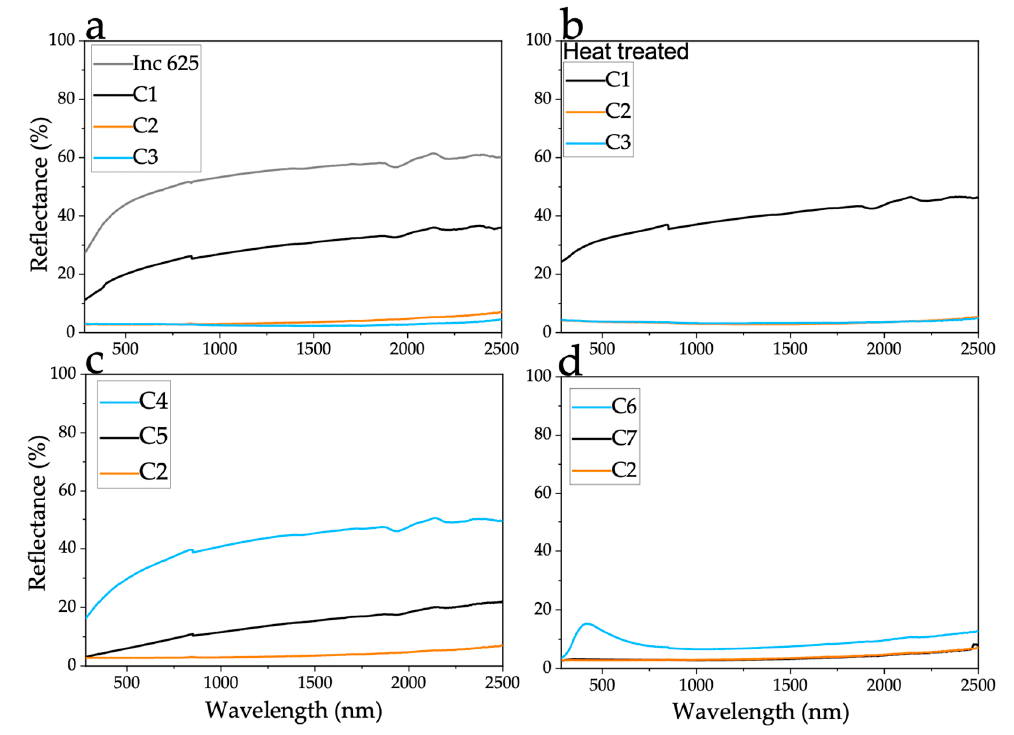
Figure 7. UV-VIS-NIR reflectance of samples. ( a ) as-converted samples at different laser beam power, ( b ) heat-treated samples at 900 ◦ C for 1 h, ( c ) as-converted samples with different amounts of precursor deposited, ( d ) as-converted precursor at different O 2 concentrations.